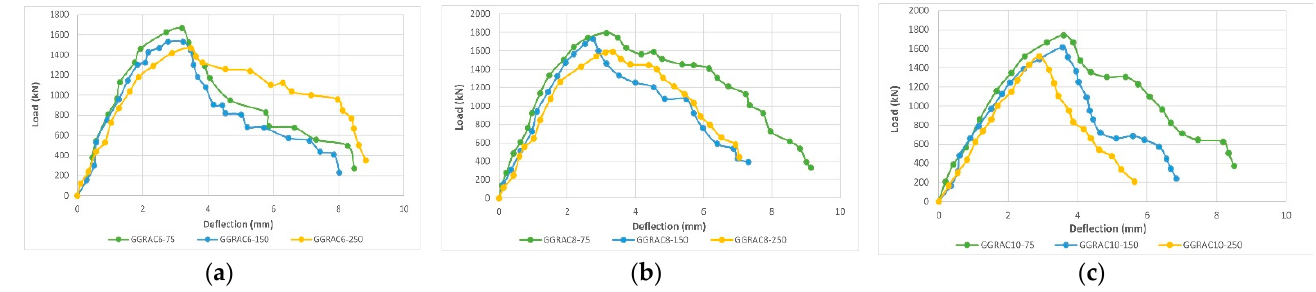
Figure 10. The load-displacement curves of GRAC columns with different reinforcement from glass fiber reinforced composite bars. ( a ) With 6 mm diameter bars and a hook pitch of 75 mm, 150 mm, and 250 mm, ( b ) with 8 mm diameter bars and a hook pitch of 75 mm, 150 mm, and 250 mm, and ( c ) with 10 mm diameter bars and a hook pitch of 75 mm, 150 mm, and 250 mm